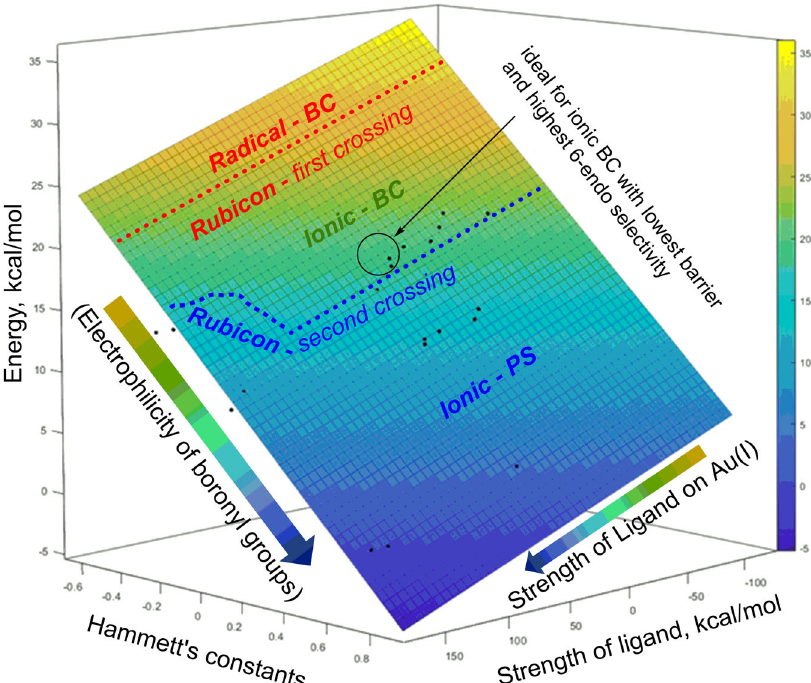
Fig. 13 Multivariate plot with 55 data points showing the dependence of activation energy (Ea) on the strength of ligand on Au(I) and the electrophilicity of the boryl group. “ Rubicon — fi rst crossing ” in red font denotes a mechanistic shift from radical-BC → ionic-BC . “ Rubicon — second crossing ” in blue font indicates a mechanistic shift from ionic-BC → ionic-SP . “ Rubicon — second crossing, ” highlights the in fl uence of ligands on Au(I) and results in the transformation of i- BC into i- SP . All boryl groups, apart from -B(NH 2 ) 2 , preferred the i- SP path when combined with anionic ligands (F, Cl, and Br) on Au(I).